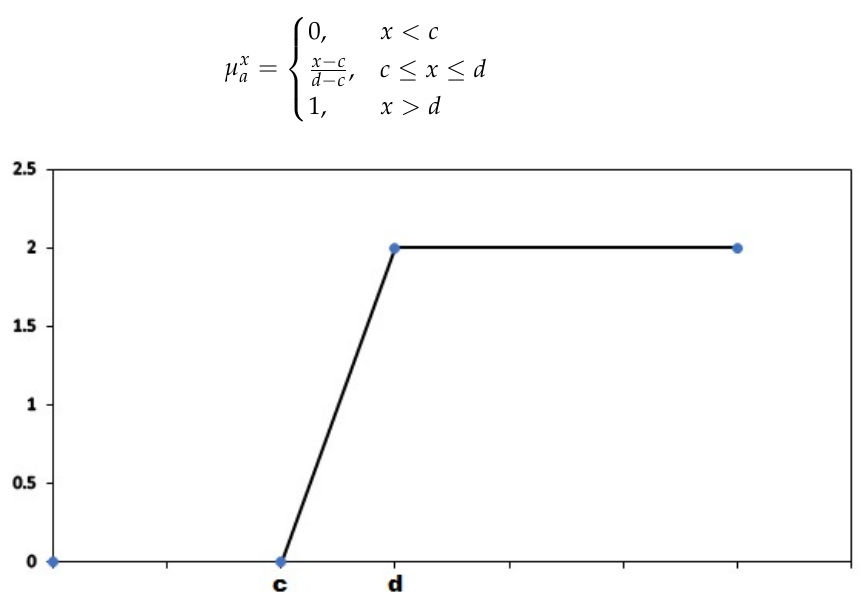
Figure 10. L–Trapezoidal